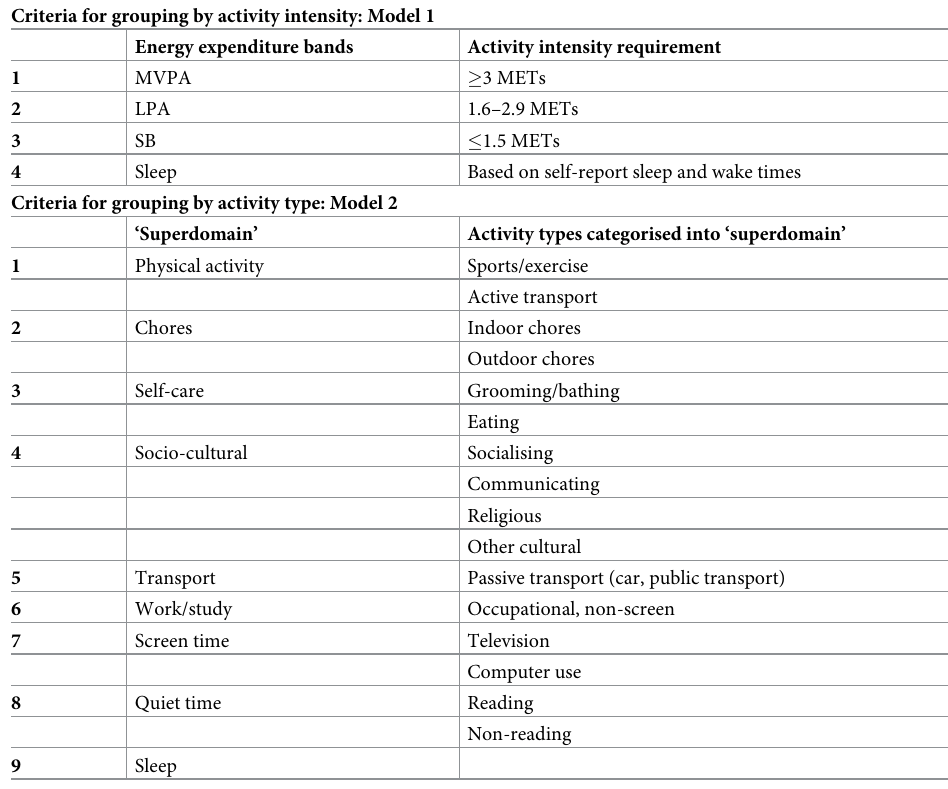
Table 1. Criteria for collating activities captured by the MARCA into four energy expenditure bands by activity intensity (Model 1), or nine common ‘superdomains’ by activity type (Model 2). Criteria for grouping by activity intensity: Model 1